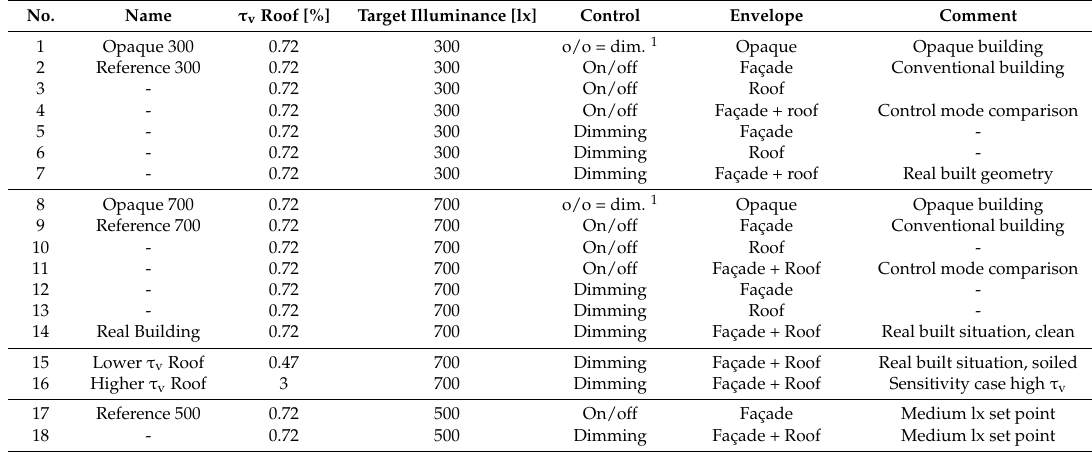
Table 6. All used parameters of the 18 simulation scenarios in